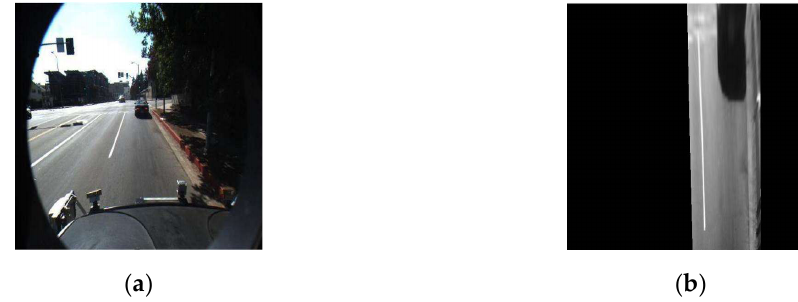
Figure 6. The corresponding original and ROI images: ( a ) Raw image; ( b ) ROI in the aerial view.